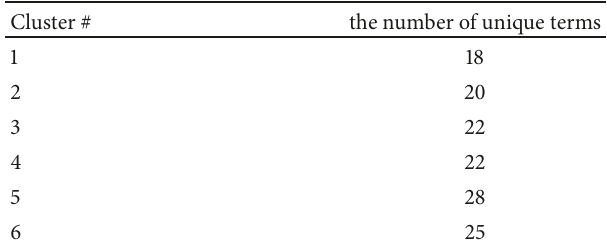
Table 6: Corpus statistics of